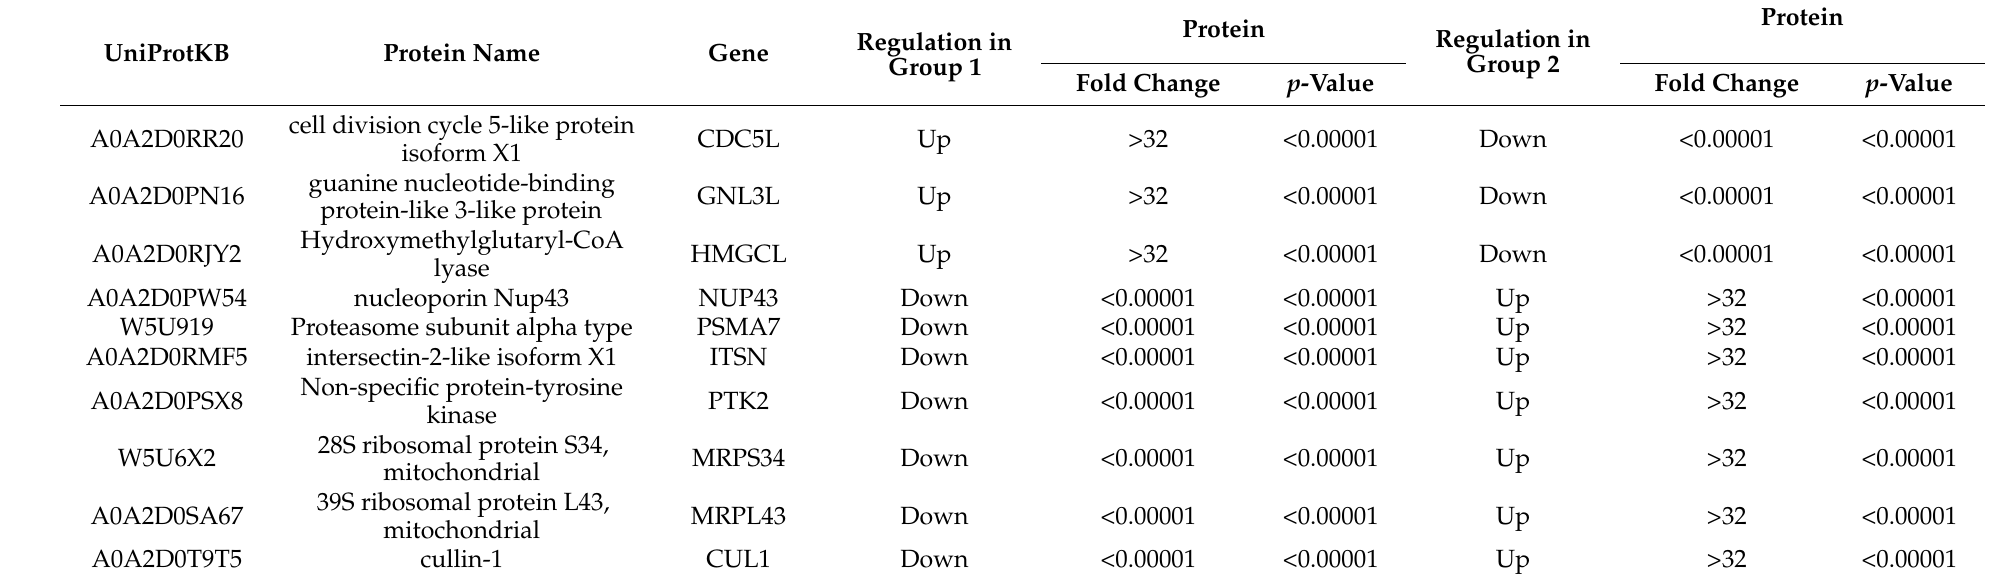
Table 5. Prediction of proteins associated with SHVV